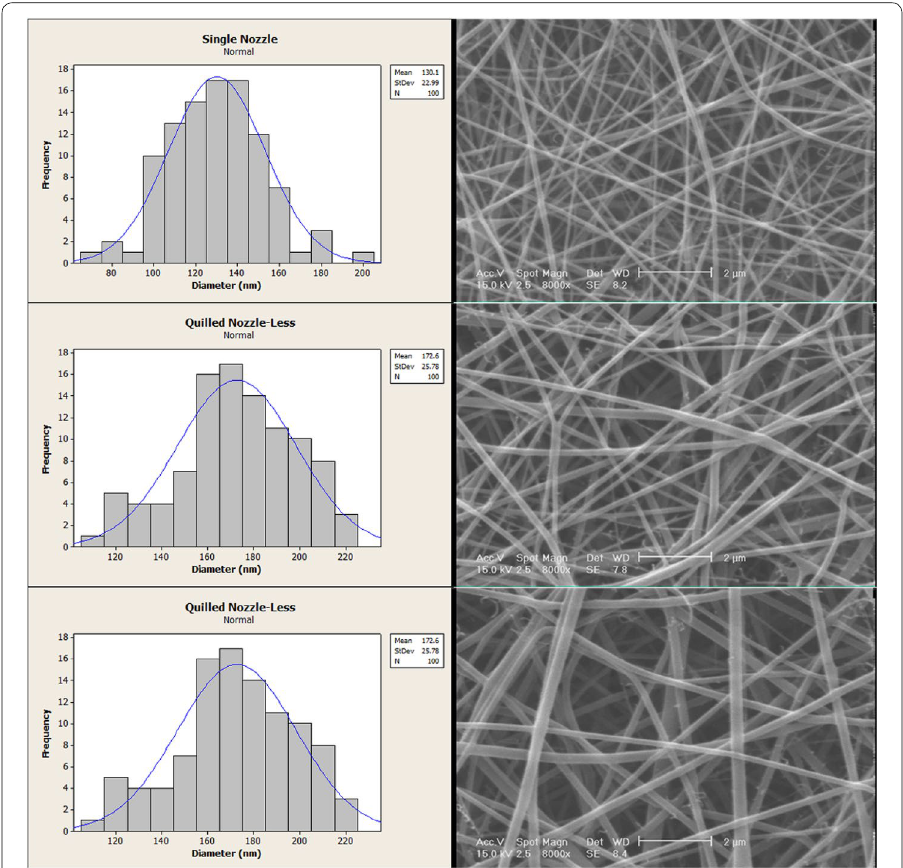
Fig. 4 SEM images of electrospun and diameter distribution of PAN nanofibers produced in three different